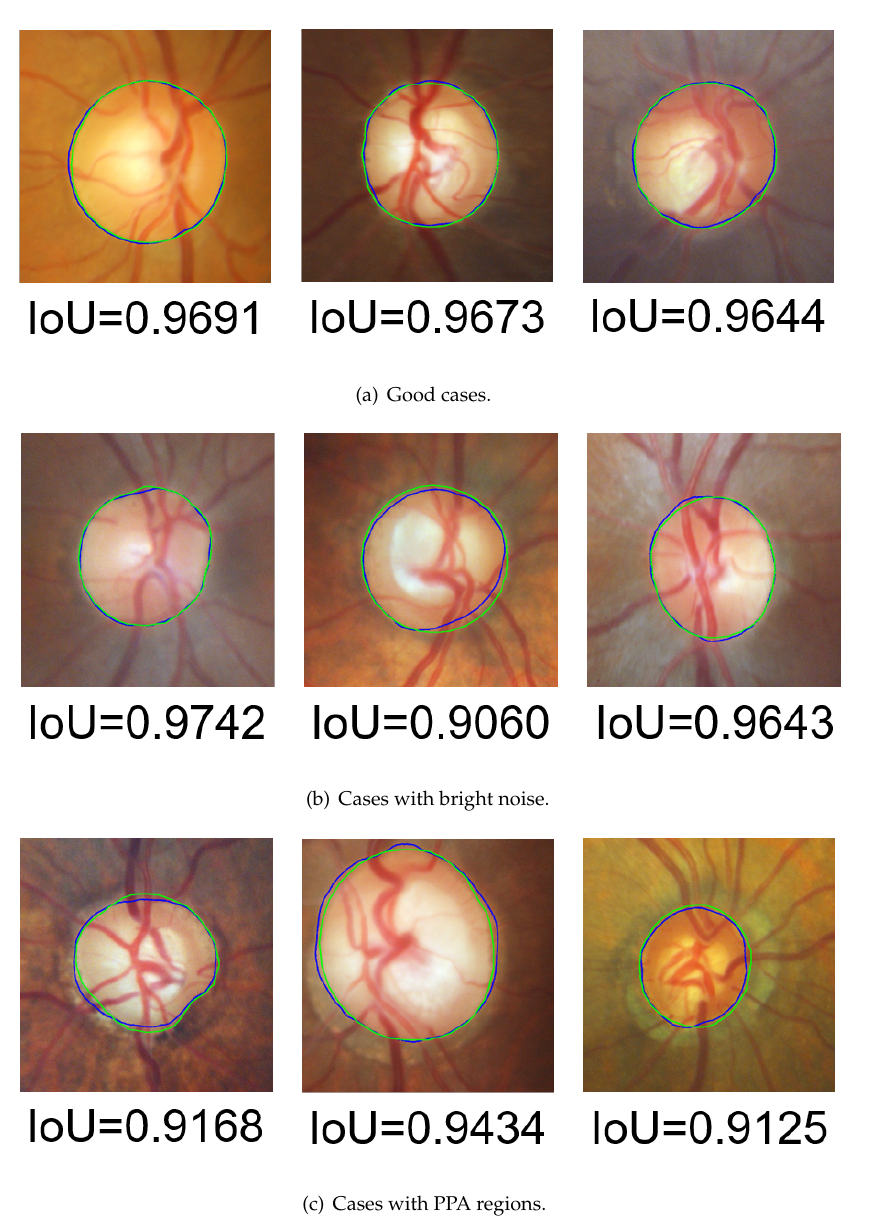
Figure 23. Segmentation result examples in the DRISHTI-GS dataset (green contour: GT, blue contour: segmentation